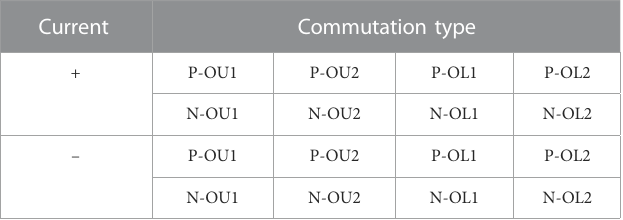
TABLE 2 16 commutation types in the 3L-ANPC inverter.